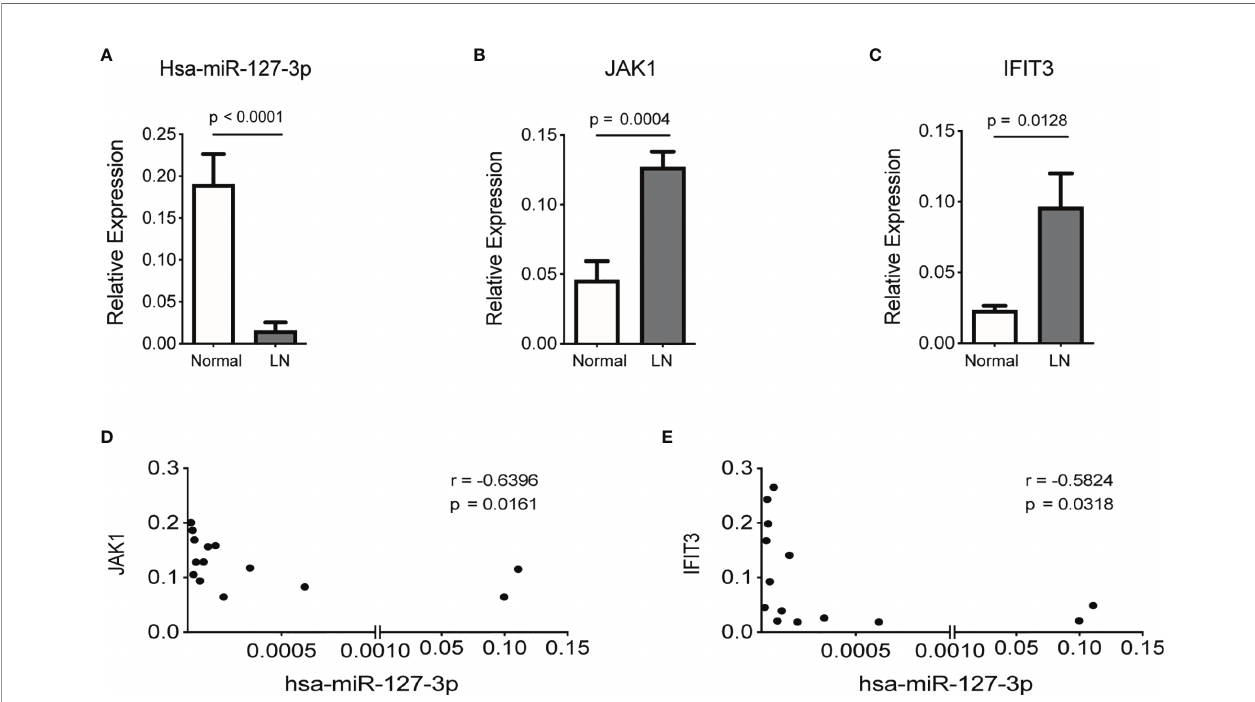
FIGURE 4 | Negatve association of the expression levels of JAK1 or IFIT3 with hsa-miR-127-3p in renal tissues of LN patients. Total RNAs were extracted from kidney biopsies of normal controls (n=11) and LN patients (n=14) and subjected to qPCR analysis for hsa-miR-127-3p (A) , JAK1 (B) and IFIT3 (C) . (D, E) Correlation between the levels of hsa-miR-127-3p and JAK1 (D) , or IFIT3 (E) in kidney biopsies from LN patients (n=14). (A-C) Data from each subject of the normal and LN groups are plotted and presented as mean±SEM. P values were determined by Mann-Whitney U-test. (D, E) Each dot represents individual LN patients. P values were determined by Spearman ’ s correlation